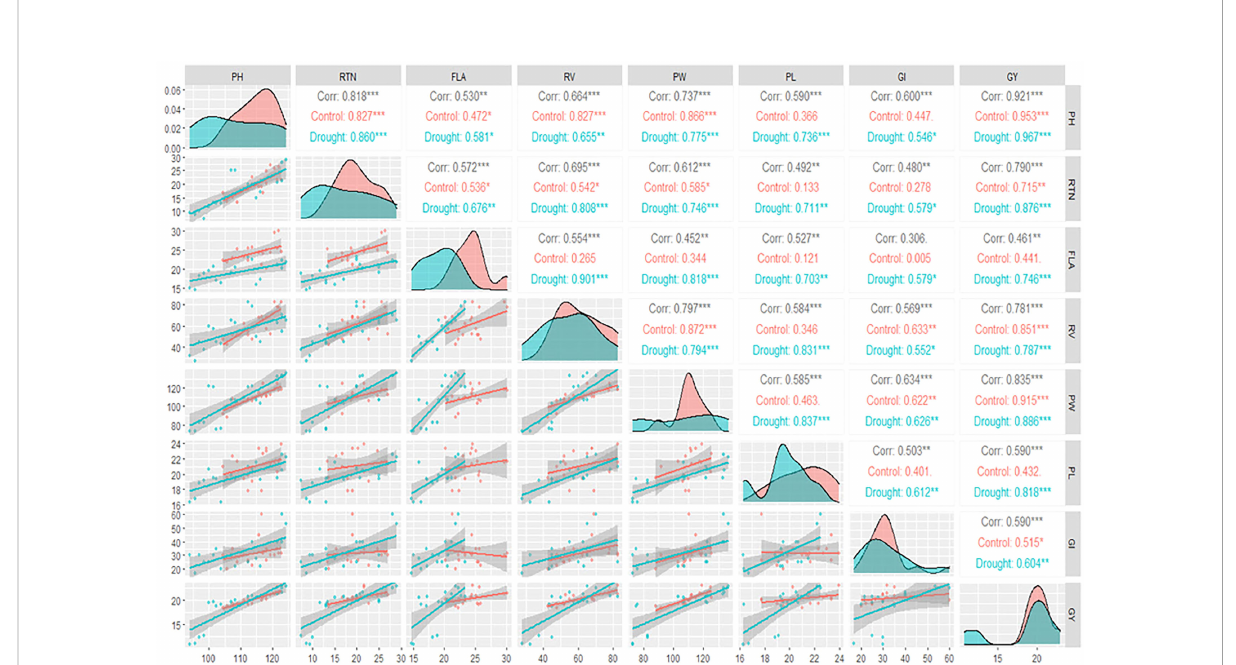
FIGURE 3 Spearman correlation matrix among the studied traits under well-watered (control) and drought treatments. The diagonal part of the produced plot represents the density plots of the studied traits, while the lower triangle represents the regression relationship with con fi dence interval between each pair of the studied traits. *, ** and *** refer to signi fi cant difference at P<0.01, 0.05 and 0.001,